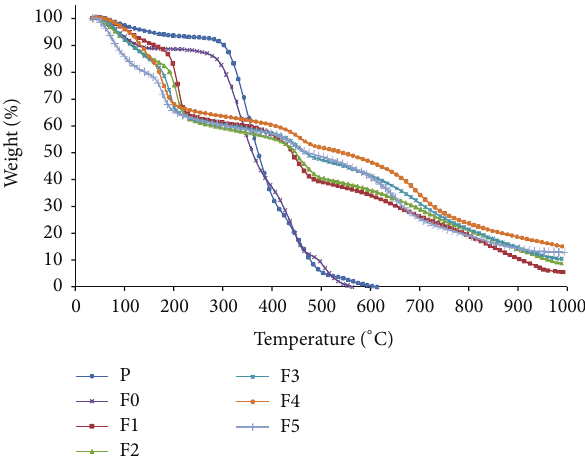
Figure 5: TGA curves of PVA powder (P), PVA (F0), and PPVA (F1–F5)